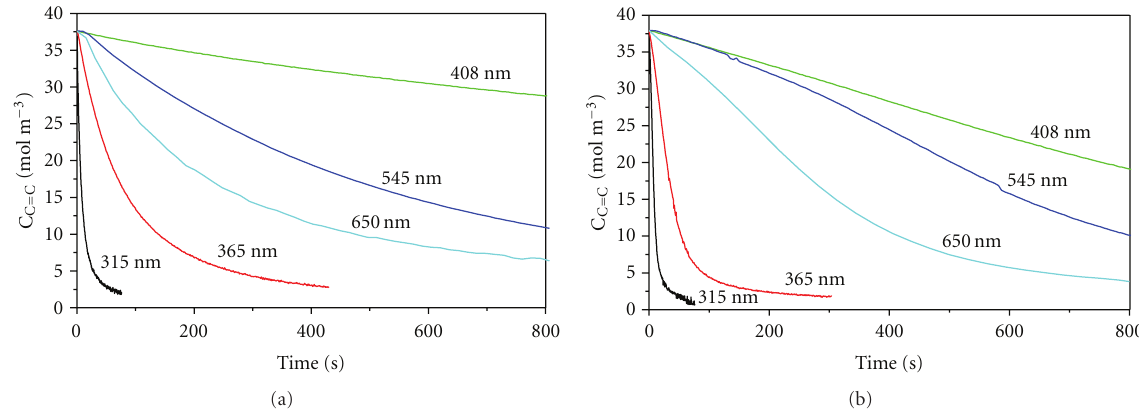
Figure 1: The decreases in the C = C bond concentration over time (at 1637cm − 1 ) during irradiation of MPS-Sb:SnO 2 /PEGDA formulations using incident light of 315, 365, 408, 545, or 650 ± 5 nm. MPS/Sb:SnO 2 = 0.19g/g; c particle = 10 vol%. (a) Sb = 0%; (b) Sb =